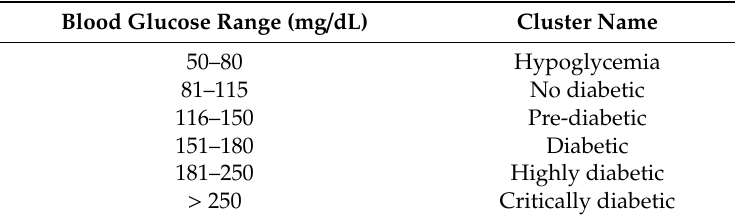
Table 8. Clusters formed based on